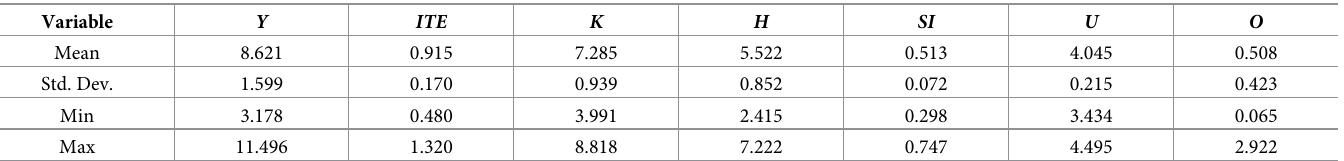
Table 1. Descriptive analysis of